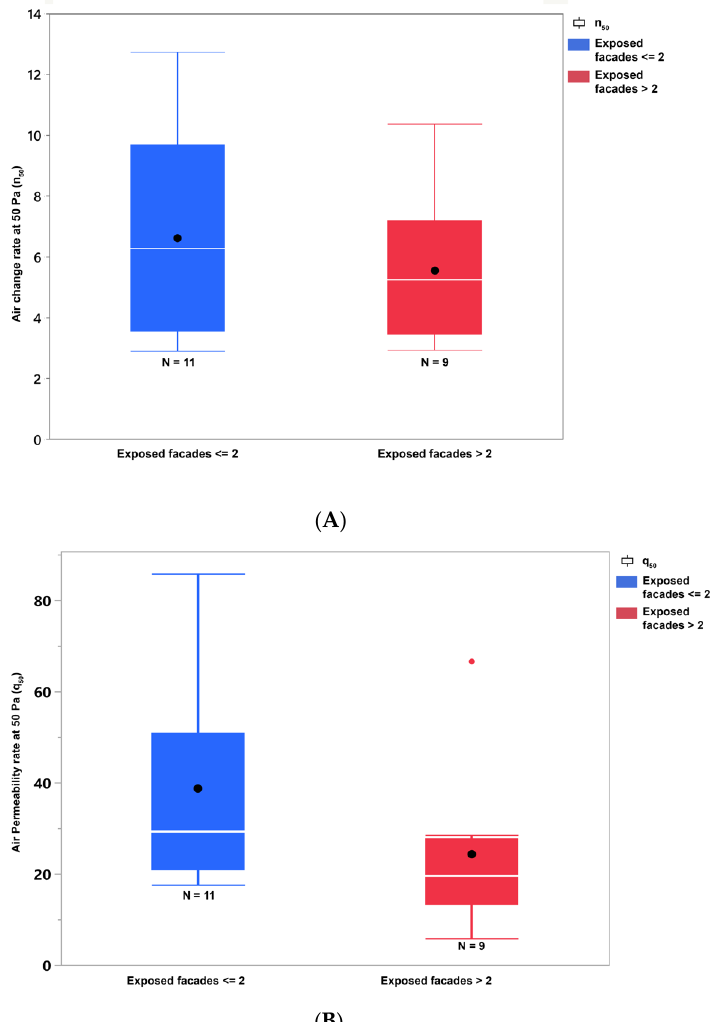
Figure 10. Box and whisker plots showing the distribution of ( A ) n 50 and ( B ) q 50 for dwellings with two or less, and more than two exposed façades (black dots show the mean value).